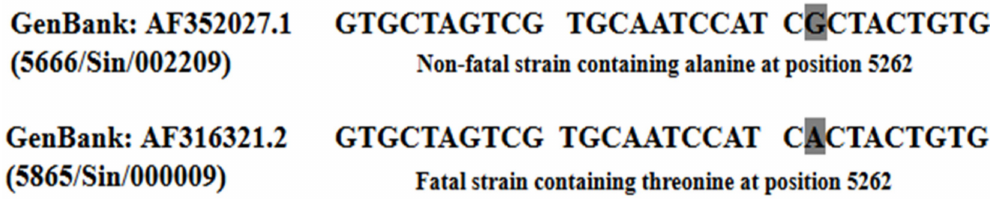
Figure 4. Comparison of a fatal (AF316321.2) and a non-fatal (AF 352027.1) strain isolated from the HFMD outbreak in Singapore (2000). Highlighted in grey shows the difference of a single nucleotide (A) was observed at nucleotide position 5262 (amino acid residue 1506) in the 3A non-structural region of the fatal strain